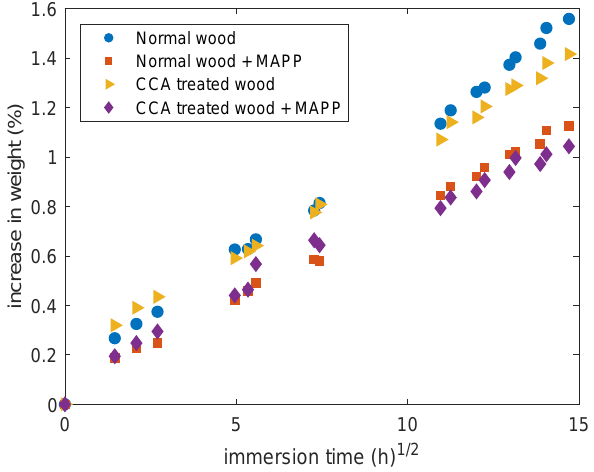
Figure 8. Increase in weight as a function of immersion time at 23 ◦